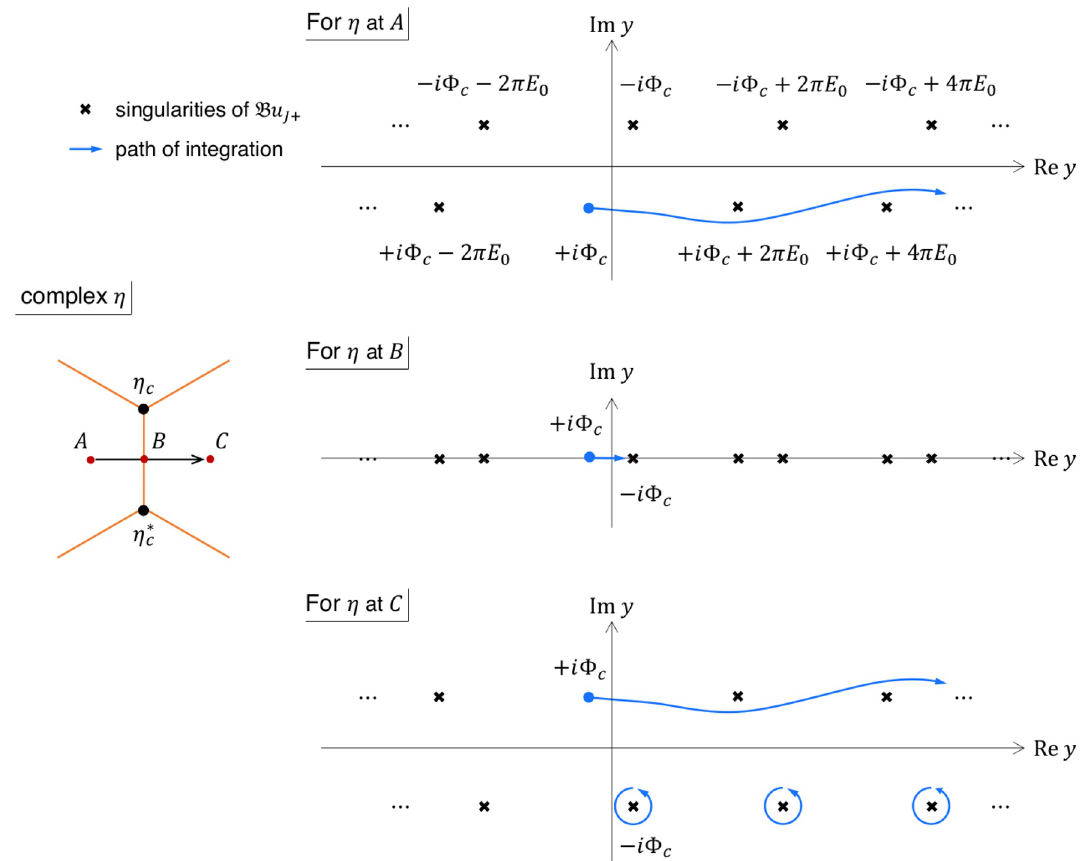
Figure 3 . The emergence of a singularity in the Laplace transform upon crossing a Stokes line in the complex time plane. This figure corresponds to the u J + case. The Laplace transform (2.22) involves an integral over y from + i Φ c ( η ) toward Re y = ∞ ; the blue curve shows a path of integration. The Borel transformed WKB solutions B u J + (2.20) have an infinite number of singularities at y = ± i Φ c ( η ) + 2 πnE 0 ( n ∈ Z ), where E 0 is real and positive [101]. For η at point A in the first Stokes region of the complex time plane, one queue of these singularities at y = + i Φ c ( η ) + 2 πnE 0 lies in the direction of the path of integration, and the path is defined to avoid these poles [102]. As η is moved to B on the Stokes line, the other queue of singularities at y = − i Φ c ( η ) + 2 πnE 0 crosses the path of integration. As η is moved across the Stokes line toward point C in the second Stokes region, the integral picks up the residue from the queue of poles. Conversely if the integral were initially defined in the second Stokes region, these residues would not be included; this discontinuity is the Stokes